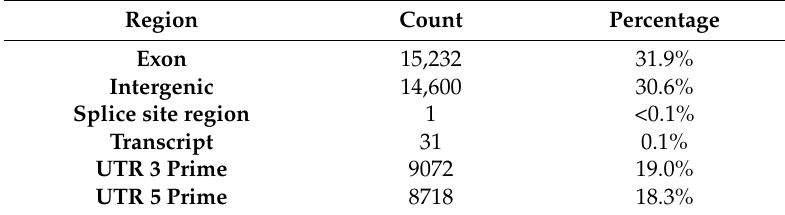
Table 5. SNP calling analysis. Number and percentage of effects by region.